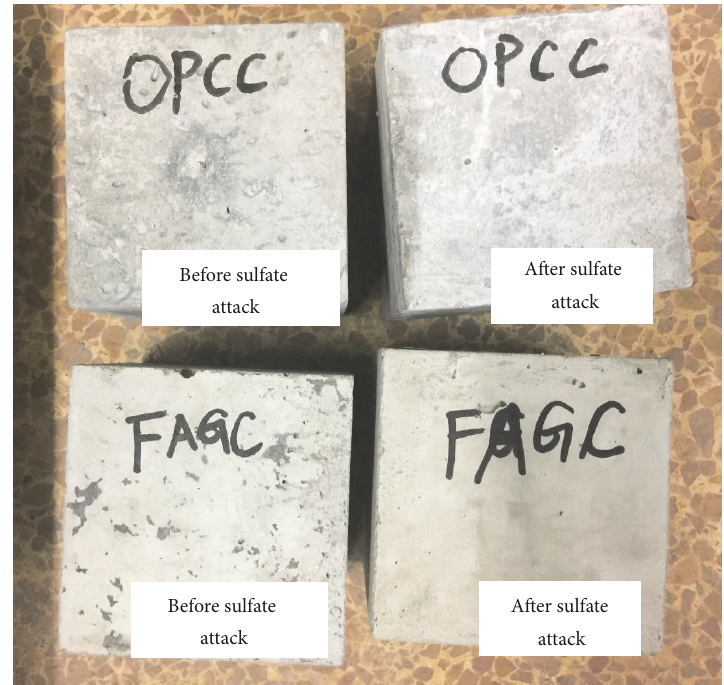
Figure 2: The visual appearance of OPCC and FAGC specimens before and after sulfate attack.